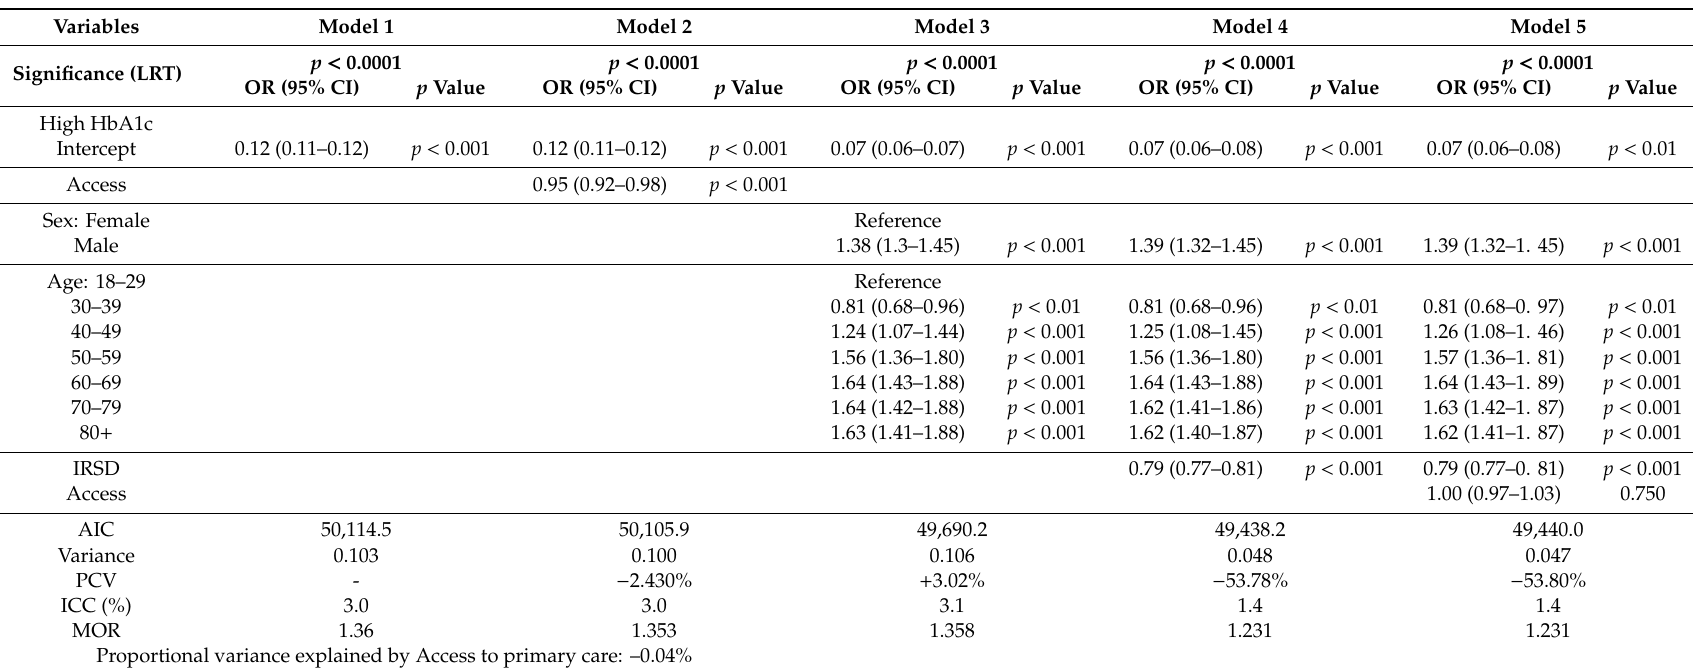
Table 4. Multilevel logistic regression model summaries of high HbA1c (HbA1c >